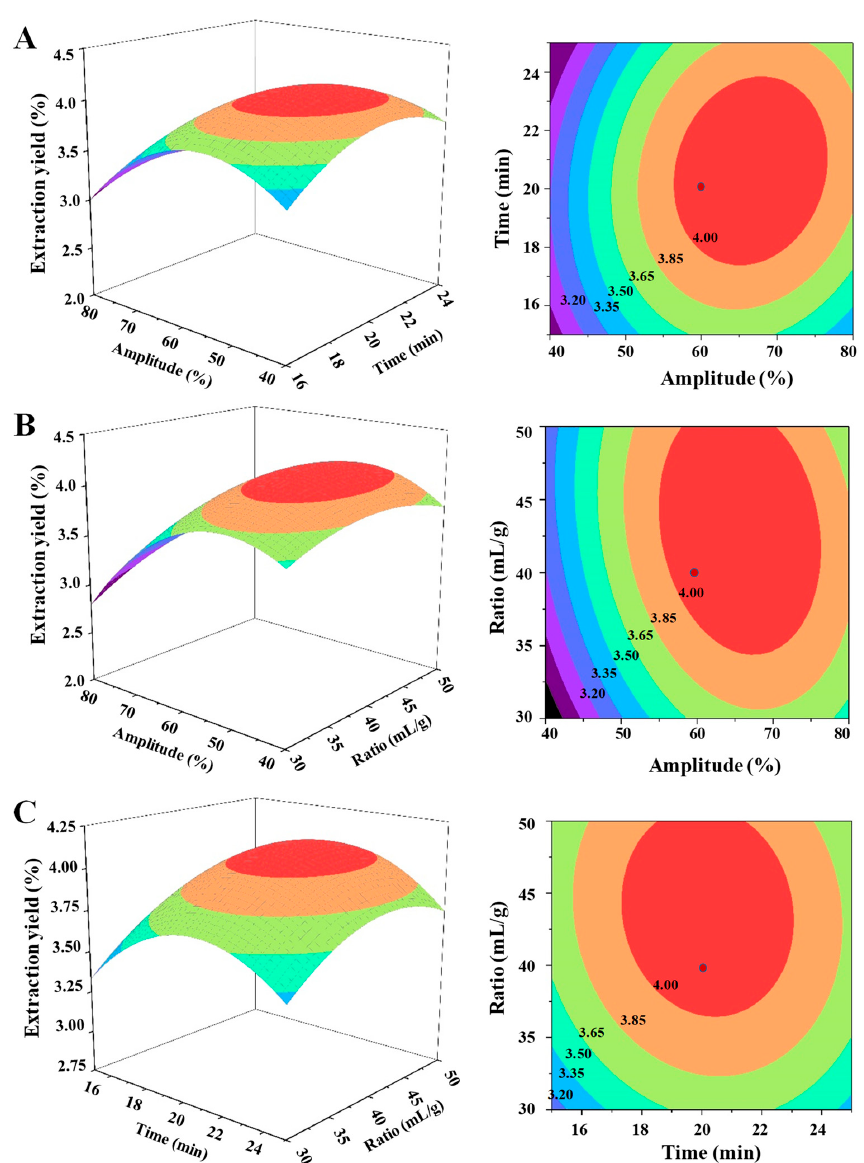
Figure 2. The three-dimensional response surface (left) and two-dimensional contour (right) plots of ultrasonic-assisted extraction: ( A ) ultrasound amplitude and ultrasound extraction time; ( B ) ultrasound amplitude and the ratio of water to raw material; and ( C ) ultrasound extraction time and the ratio of water to raw material.